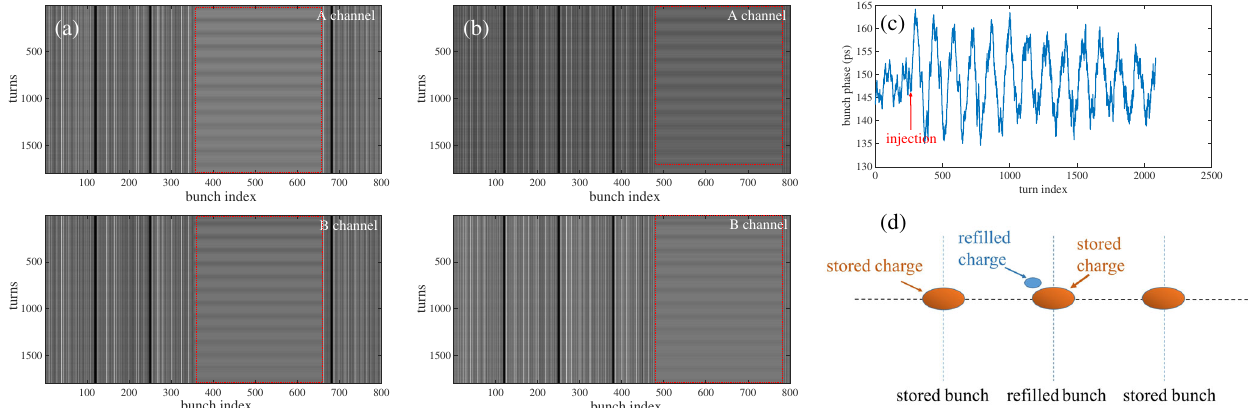
FIG. 2. Data is drawn into images. (a) and (b) show two sets data with two channels. B channel is similar to A channel. The difference between them is caused by the delay(300 ps). With both of them, we can remove the influence of different charge quantities to get the phase oscillation parameters. The area in the red dotted box is refilled bunch. There is only one refilled bunch, but we copy it into three hundred bunches to increase its visual size. Outside is stored bunches. (c) shows refilled bunch longitudinal phase. (d) shows injection process. The refilled bunch is consisted of refilled charge and stored charge.The difficulty of our work is how to remove the oscillation of refilled charge from the refilled